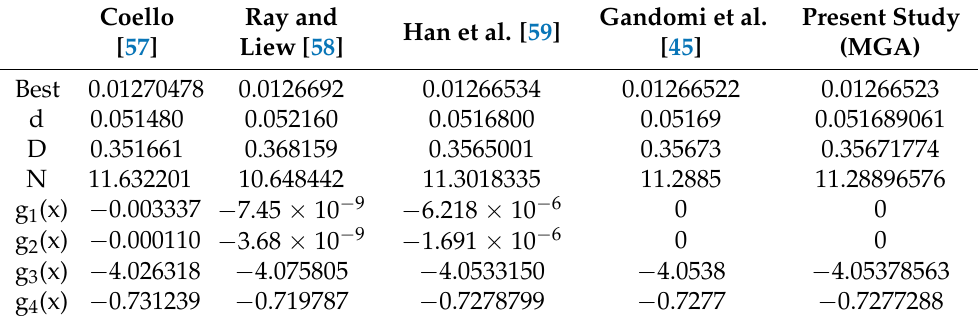
Table A3. Comparison of the best solutions for the tension or compression spring design problem.